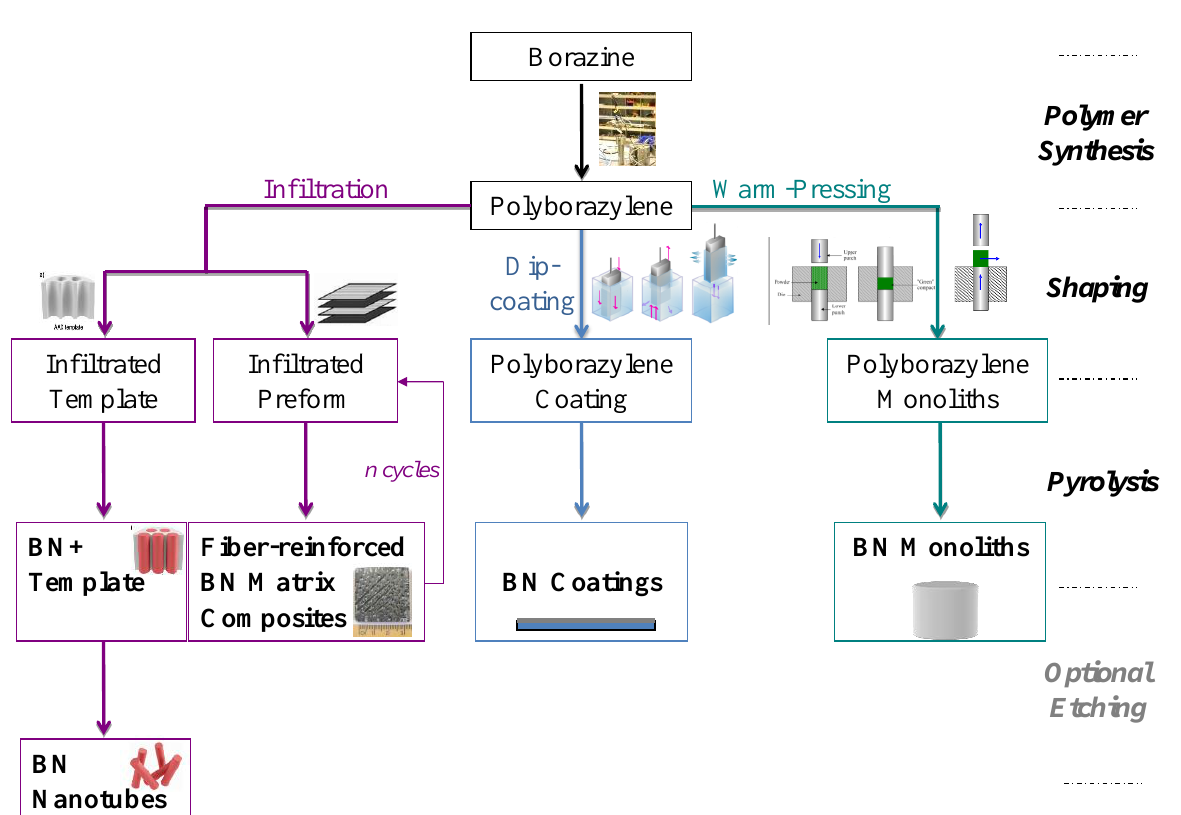
Figure 4. Examples of shaped BN derived from